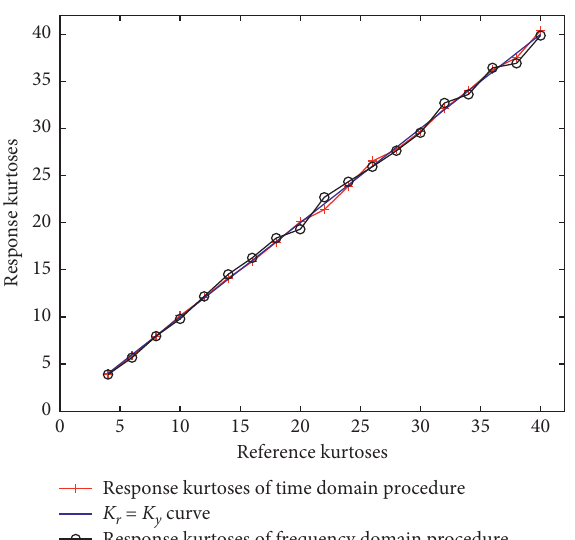
Figure 19: Numerical relationship between the reference kurtoses and the response kurtoses with the application of the proposed window function: K r � K y curve (solid line); averaged kurtoses of the response generated by the time-domain procedure (broken line with plus signs); averaged kurtoses of the response generated by the frequency-domain procedure (broken line with circles).